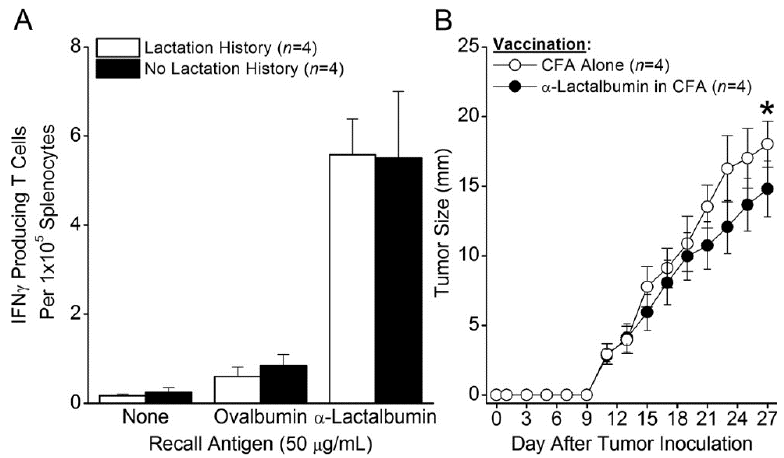
Figure 2. Effect of Lactation History on Induction of Tumor Immunity. Eight week old BALB/c female mice were mated and allowed to undergo one complete cycle of pregnancy, lactation, breastfeeding, and weaning. ( A ) Four weeks after weaning, parous mice and age-matched non-parous female mice with no prior lactation history were immunized with 100 µ g α -lactalbumin in CFA. Four weeks after immunization, splenocyte frequencies of type-1 IFN γ -producing T cells were determined by ELISPOT analysis in recall responses to the priming α -lactalbumin immunogen. Frequencies of α -lactalbumin-responsive IFN γ -producing T cells that mediate immune protection against 4T1 tumors were virtually identical in mice with and without a prior history of lactation (mean ~1 per 20,000 splenocytes). ( B ) Four weeks after weaning, parous mice were immunized with α -lactalbumin in CFA or with CFA alone. Three weeks after vaccination, mice were inoculated with 1 ˆ 10 4 4T1 breast cancer cells by subcutaneous injection in 100 µ L PBS. Tumors were measured by Vernier caliper every other day until tumors reached 17 mm in any direction. Tumor progression analysis showed significant inhibition of 4T1 tumor growth (asterisk indicates p < 0.01) in mice immunized with α -lactalbumin compared to age-matched female mice immunized with CFA alone. Error bars show ˘